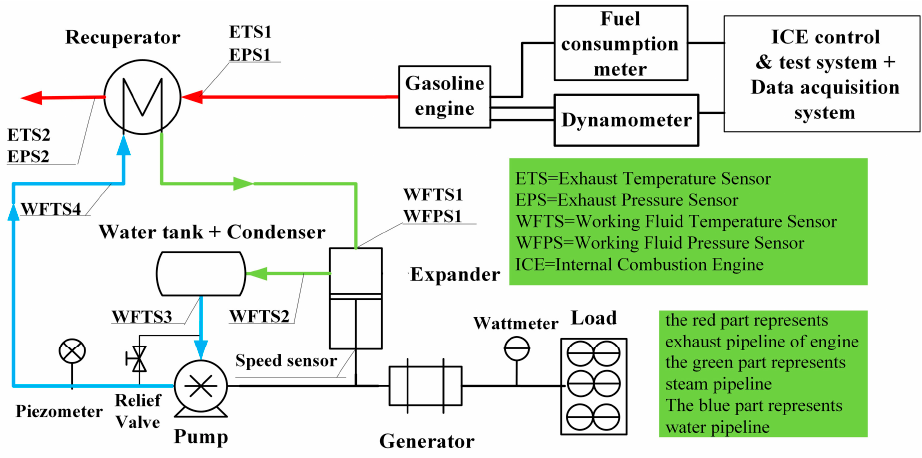
Figure 1. Schematic of the test bench.